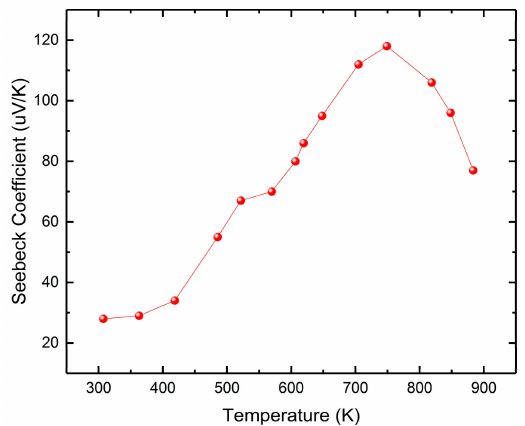
Figure 8. Seebeck coe ffi cient thermal evolution, showing a shoulder between 500–570